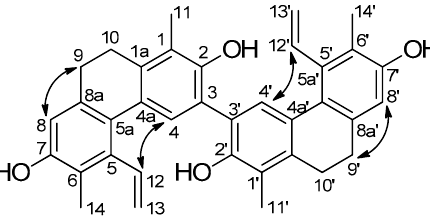
Figure 4. NOESY correlations of Compound 2 .